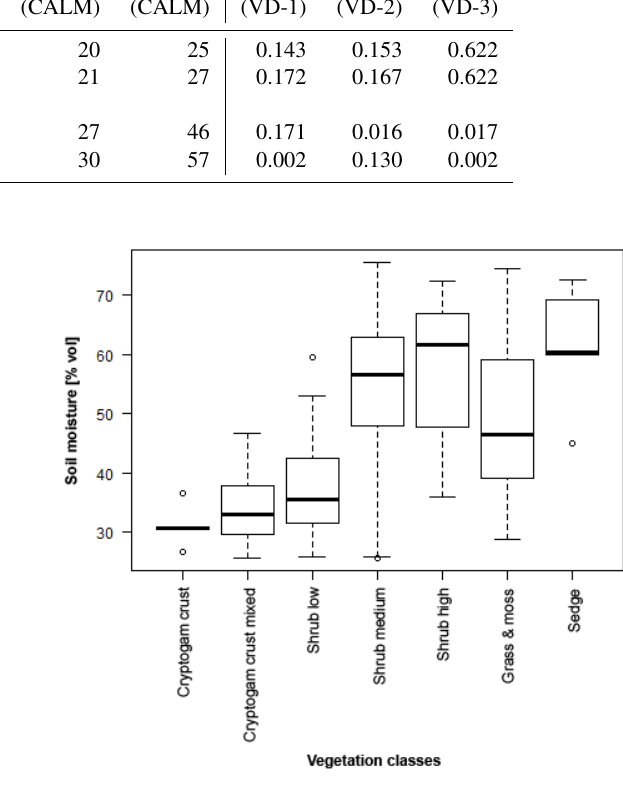
Figure 3. Box plot for mean soil moisture values of three acquisi- tion dates in late August 2015 for vegetation types at the CALM